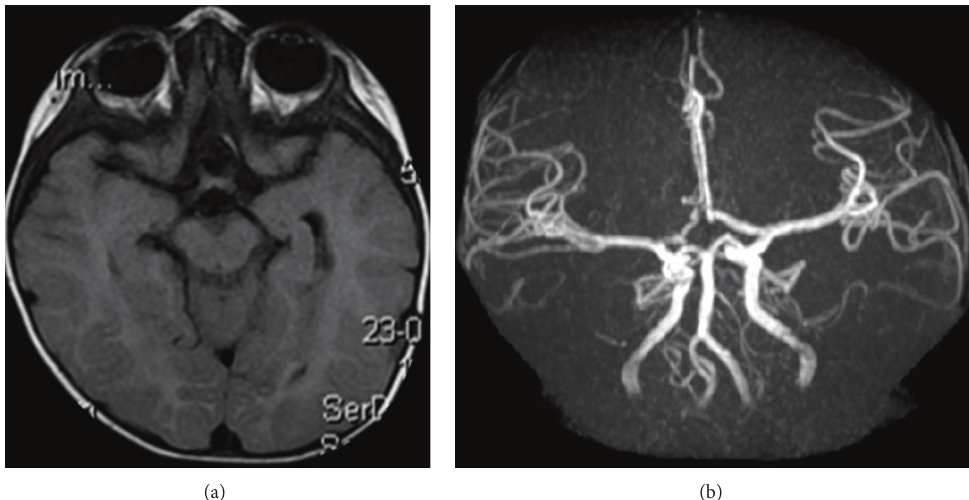
Figure 5: MRA performed 3 months after the initial hemorrhagic event. (a) Considerable volume reduction of the thrombosed aneurysm; (b) patent right ACA. No residual aneurysmal neck was documented.